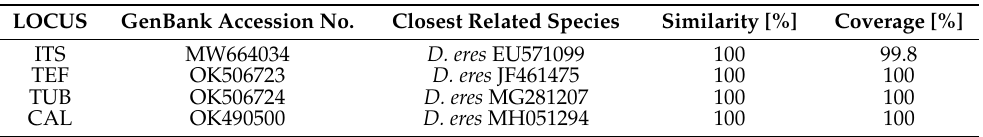
Table 1. Species most closely related to endophytic Diaporthe based on ITS, TEF, TUB, and CAL sequences using BLASTn analysis.